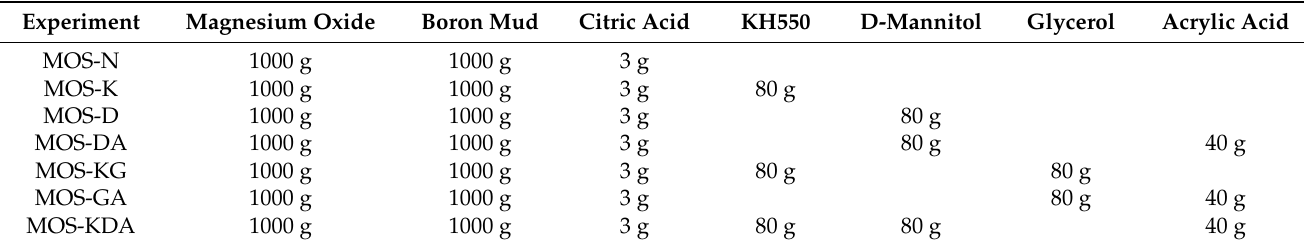
Table 2. Mixing design for magnesium oxysulfate cement paste.